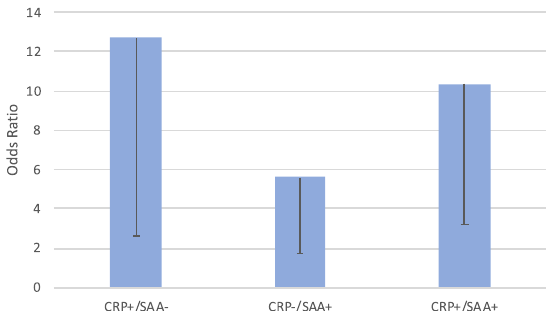
Fig. 4 Multivariable conditional logistic regression of CRP and SAA and risk of relapsed breast cancer (additive scale, HER2 − subjects). Description: Error bars represent lower 95% con fi dence interval.